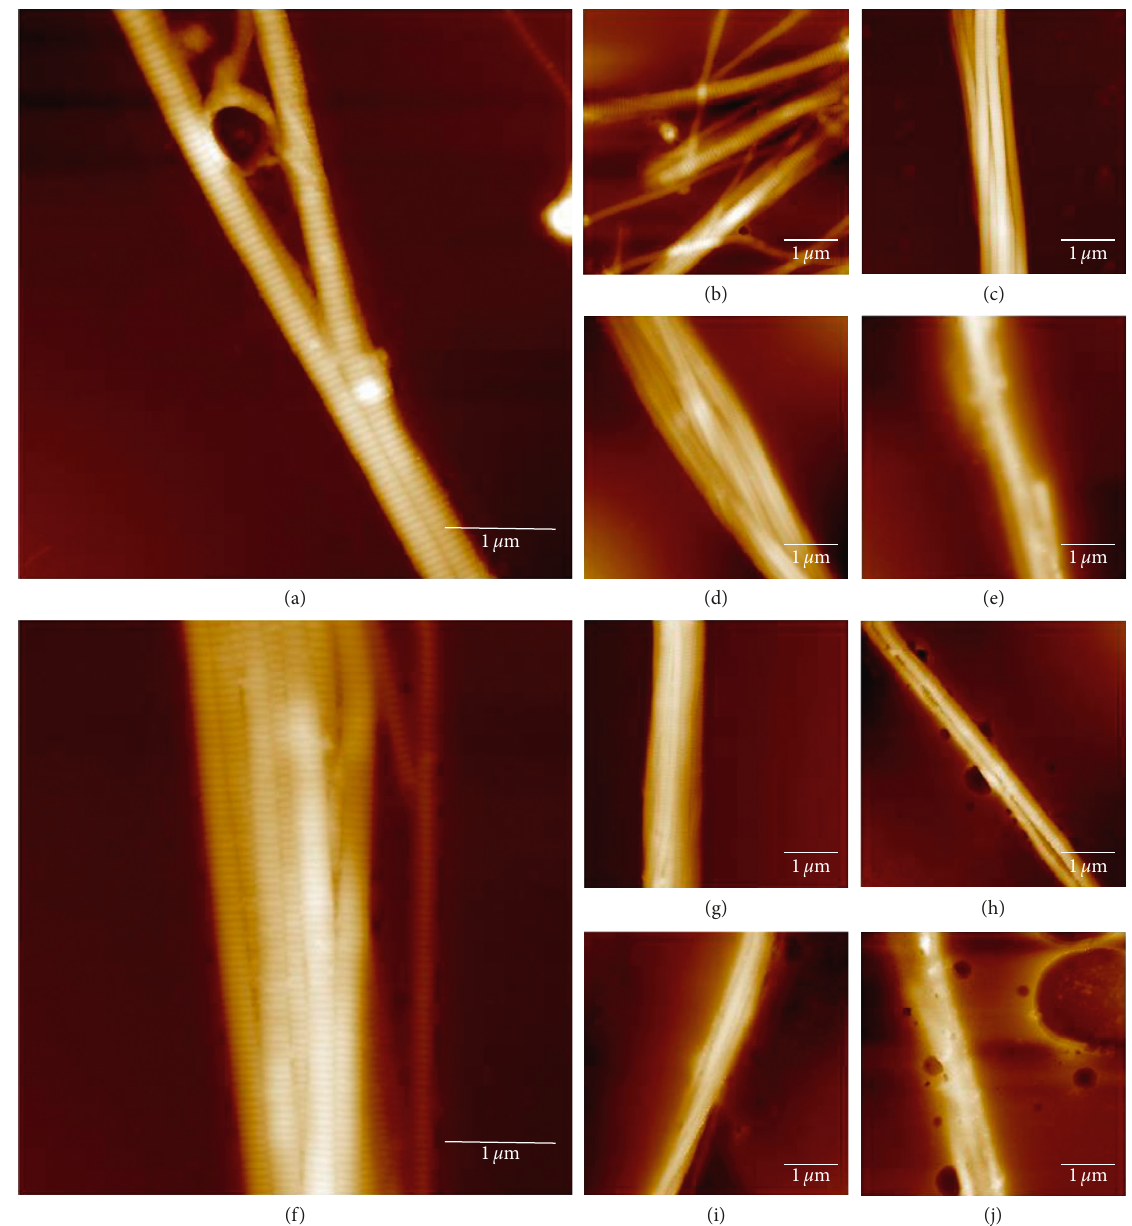
Figure 4: Typical AFM height images of collagen fibers treated by microwave. (a–e) 10-minute group and (f–j) 15-minute group were processed at 140, 280, 420, 560, and 700W,